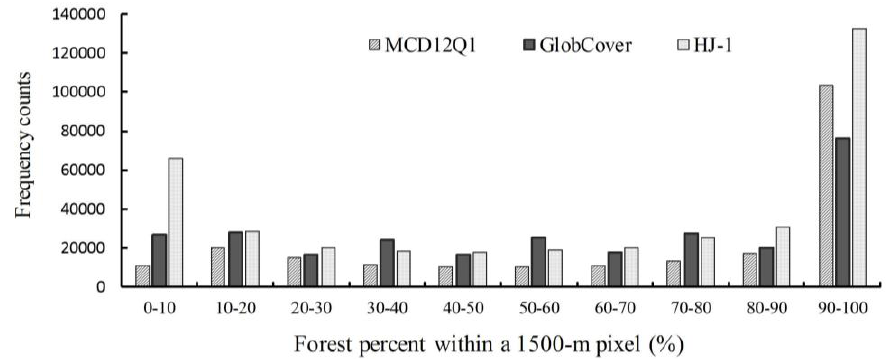
Figure 8. Pixel frequency of different forest percentage from the HJ-1 2010, GlobCover 2009 and MCD12Q1 2009 datasets.